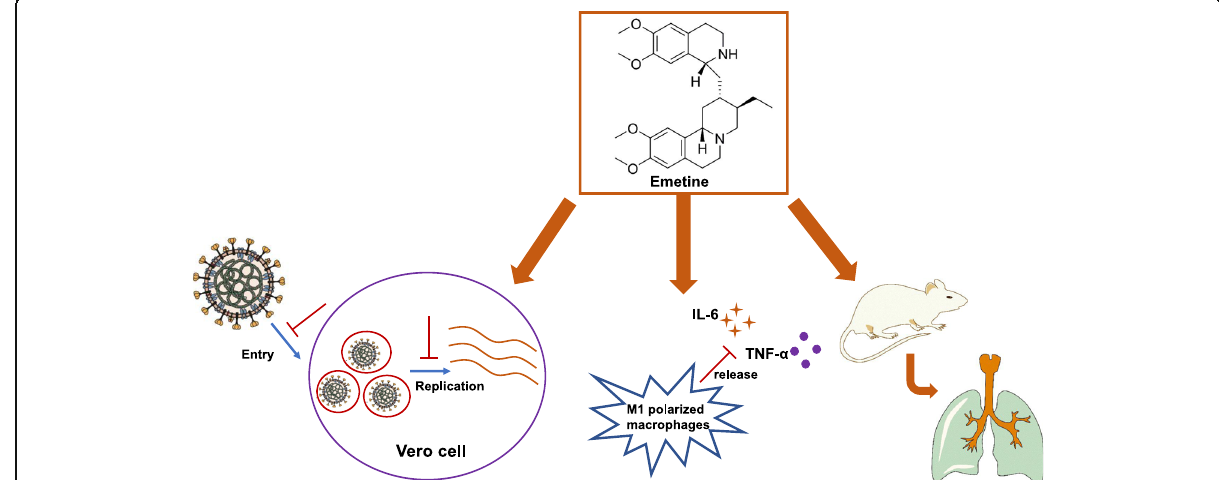
Fig. 4 Graphic illustration of action Model for Emetine as Anti-SARS-CoV-2 Virus Therapy. Firstly, Emetine could potently inhibit the SARS-CoV-2 virus replication and displayed virus entry blocking effect in Vero cells at low dose. Secondly, Emetine could significantly reduce the LPS induced IL-6 protein level and moderately reduce the TNF- α protein level in the M1 polarized THP-1 macrophages. In addition, in vivo animal PK study revealed that Emetine was enriched in the lung tissue and had a long retention time. In summary, the potent in vitro antiviral replication efficacy, the high enrichment in target tissue combining with the well documented safety profiles in human indicated that low dose of Emetine might be a potentially effective anti-SARS-CoV-2 infection